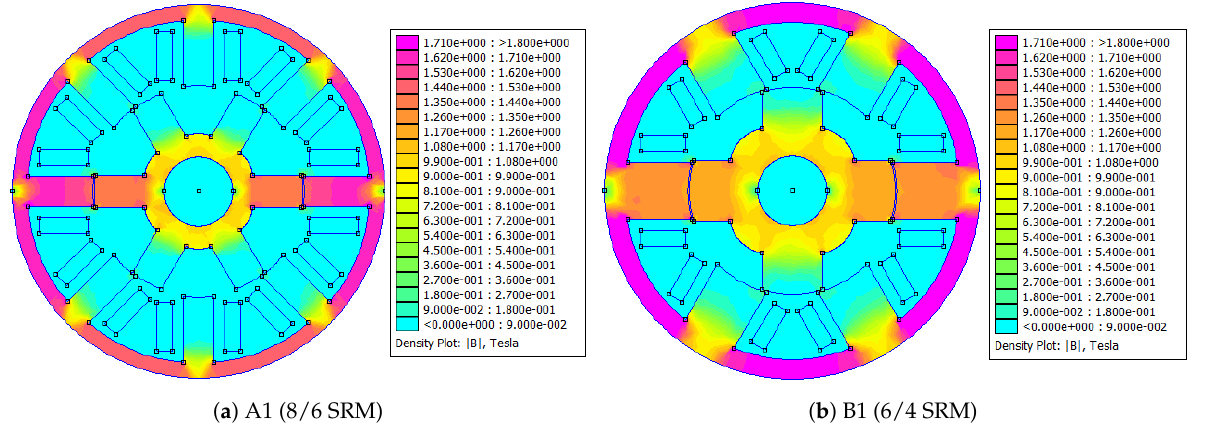
Figure 9. Flux density of selected optimal designs in an aligned position.